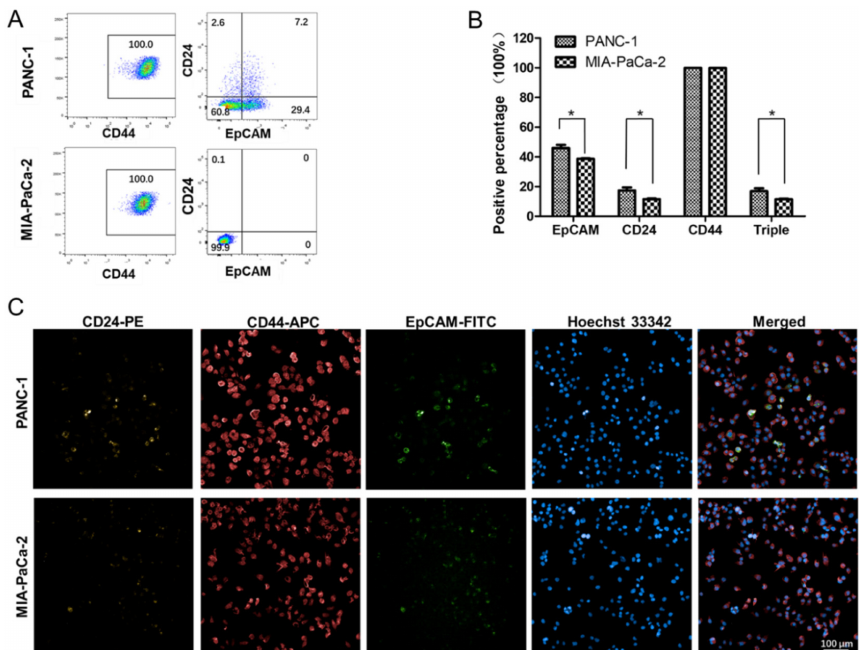
Figure 4. Analysis of pancreatic cancer stem cell surface markers CD24, CD44, and EpCAM in PANC-1 and MIA-PaCa-2. The presence of CD24, CD44, and EpCAM were determined by flow cytometry and immunocytochemistry examination. ( A ) The percentage of triple-positive cells was 7.2% in PANC-1 and 0% in MIA-PaCa-2 through flow cytometry analysis. ( B ) In PANC-1 analyzed with immunocytochemistry examination, the percentage of CD24 + , EpCAM + , and CD24 + CD44 + EpCAM + cells was 17.3 ± 3.7%, 46.0 ± 3.5% and 16.8 ± 3.6%, while in MIA-PaCa-2, the percentage was 11.5 ± 0.7%, 38.7 ± 0.5% and 11.4 ± 0.7%, respectively. ( C ) Images of PANC-1 and MIA-PaCa-2 cells stained with anti-human CD44, anti-human EpCAM, and anti-human CD24 antibody. The right panel was the merged images. Data are presented as the mean ± standard deviation (SD) of three independent experiments. * P < 0.05 in comparison with the corresponding cells using Student’s t -test.